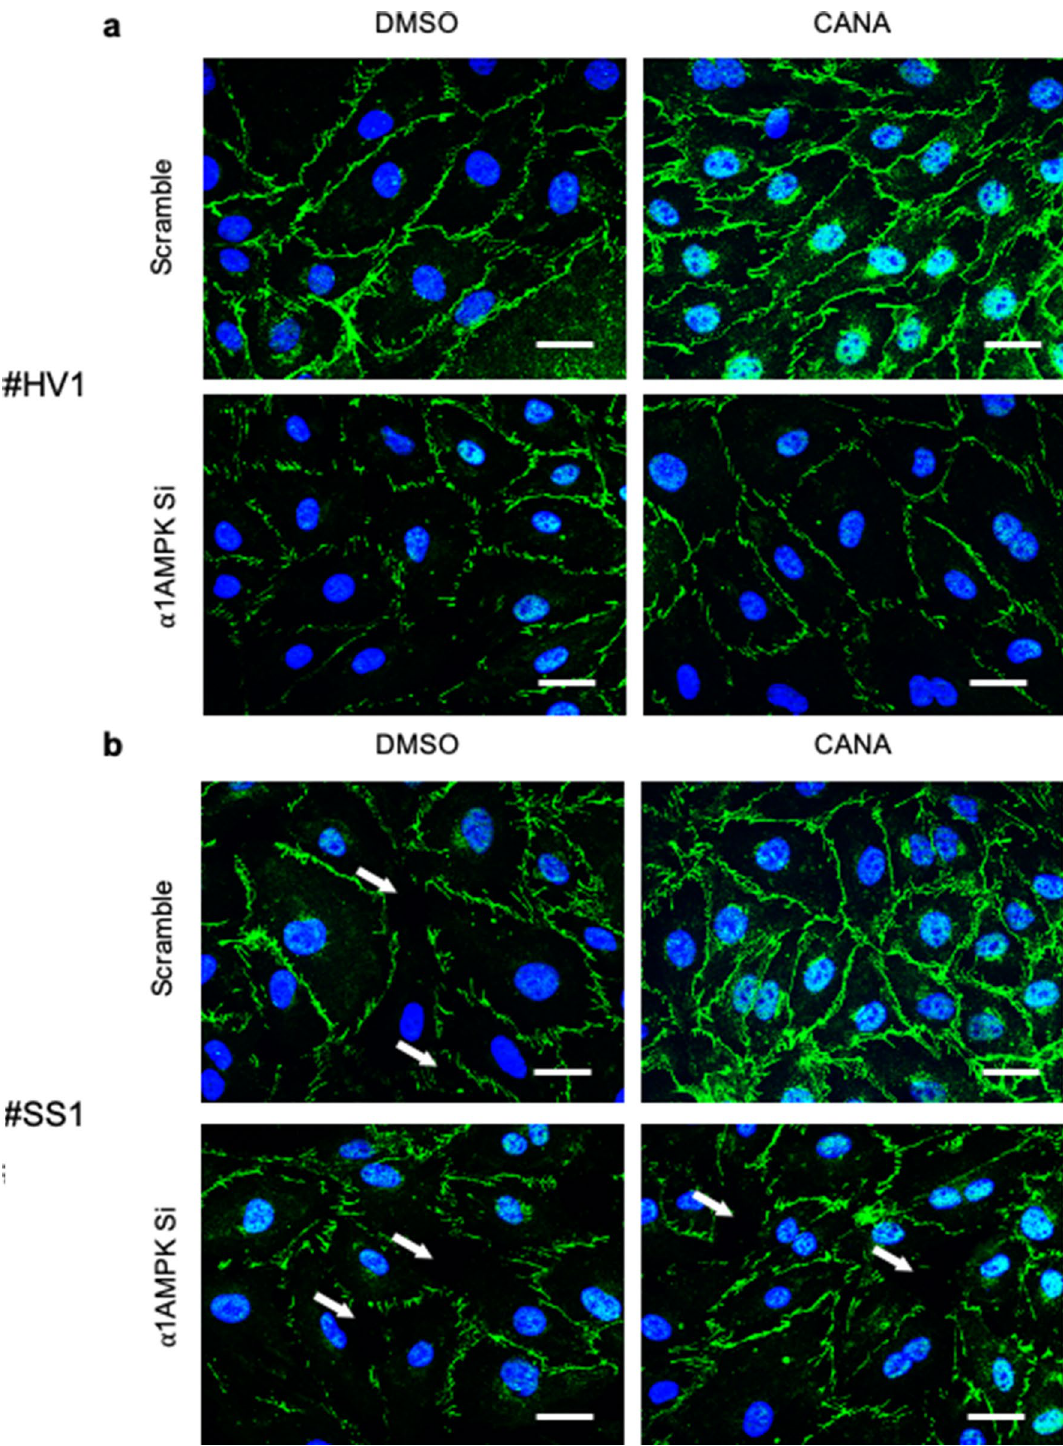
Figure 5. AMPK activation by Canagliflozin protects VE-Cad integrity in HMECs challenged with human septic plasma. VE-Cad immunostainings performed on HMECs. HMECs were transfected with scramble or ⍺ 1AMPK targeting siRNA (50 nM) for 48 h, before being treated with canagliflozin (3 µM) or DMSO for one hour, then incubated with 10% plasma of ( a ) healthy volunteers (HV) or ( b ) septic shock patients (SS) for 30 min. Typical examples of pictures are shown. The experiment has been repeated with 4 different donors for each group (see Supplemental Fig. 2). Intercellular gaps are indicated by white arrows. Nuclei were stained with DAPI. Scale bar, 50